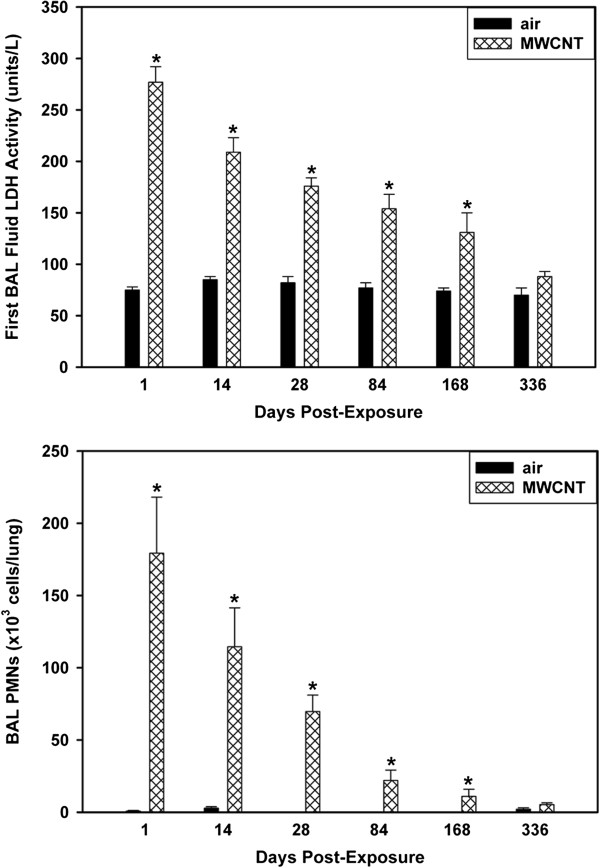
BAL analysis of pulmonary injury and inflammation. Mice were exposed by inhalation exposure to air (vehicle) or MWCNTs (5 mg/m3) for 12 days. BAL LDH and BAL PMNs studies were conducted at 1, 14, 28, 84, 168 and 336 days post-exposure. Cytotoxicity was assessed by BAL fluid LDH activities and pulmonary inflammation by BAL polymorphonuclear leukocytes. BAL fluid LDH activities (upper panel) and BAL PMNs (lower panel) were significantly elevated above respective clean-air controls from 1 to 168 days post-exposure (Mean ± S.E., N = 6-8). An asterisk indicates air-exposed controls were significantly lower (p < 0.05) in comparison to the corresponding MWCNT-exposed group. Highly significant decreases in LDH (P < 0.0001) and BAL PMNs (P < 0.002) with post-exposure time were determined. BAL protein was also measured and followed the same pattern as LDH (data not shown).